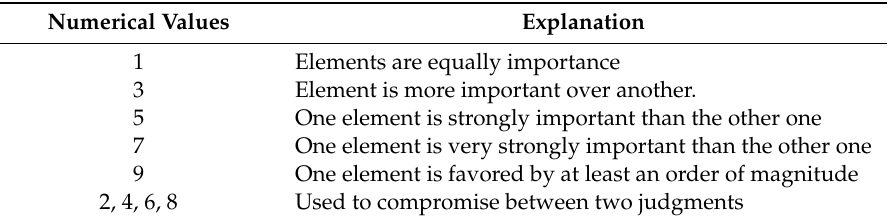
Table 2. Saaty’s determination scale for relative weight score of elements [36]. Numerical Values